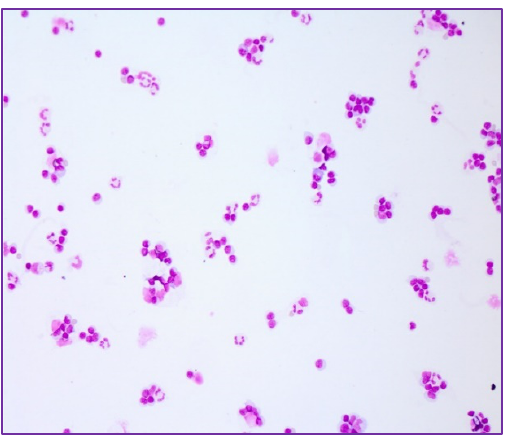
Figure 1. Mild mixed pleocytosis with leukocytes, monocytes and some neutrophils in the CSF of the index patient (20× magnification).